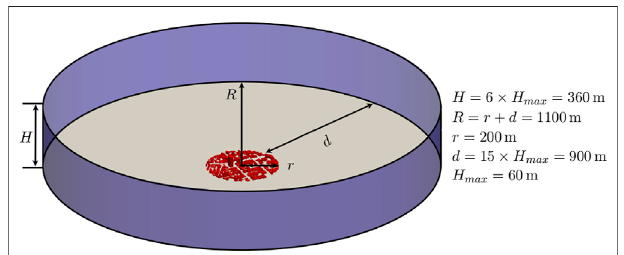
FIGURE 1 | The computational domain. H max is the height of the highest building.